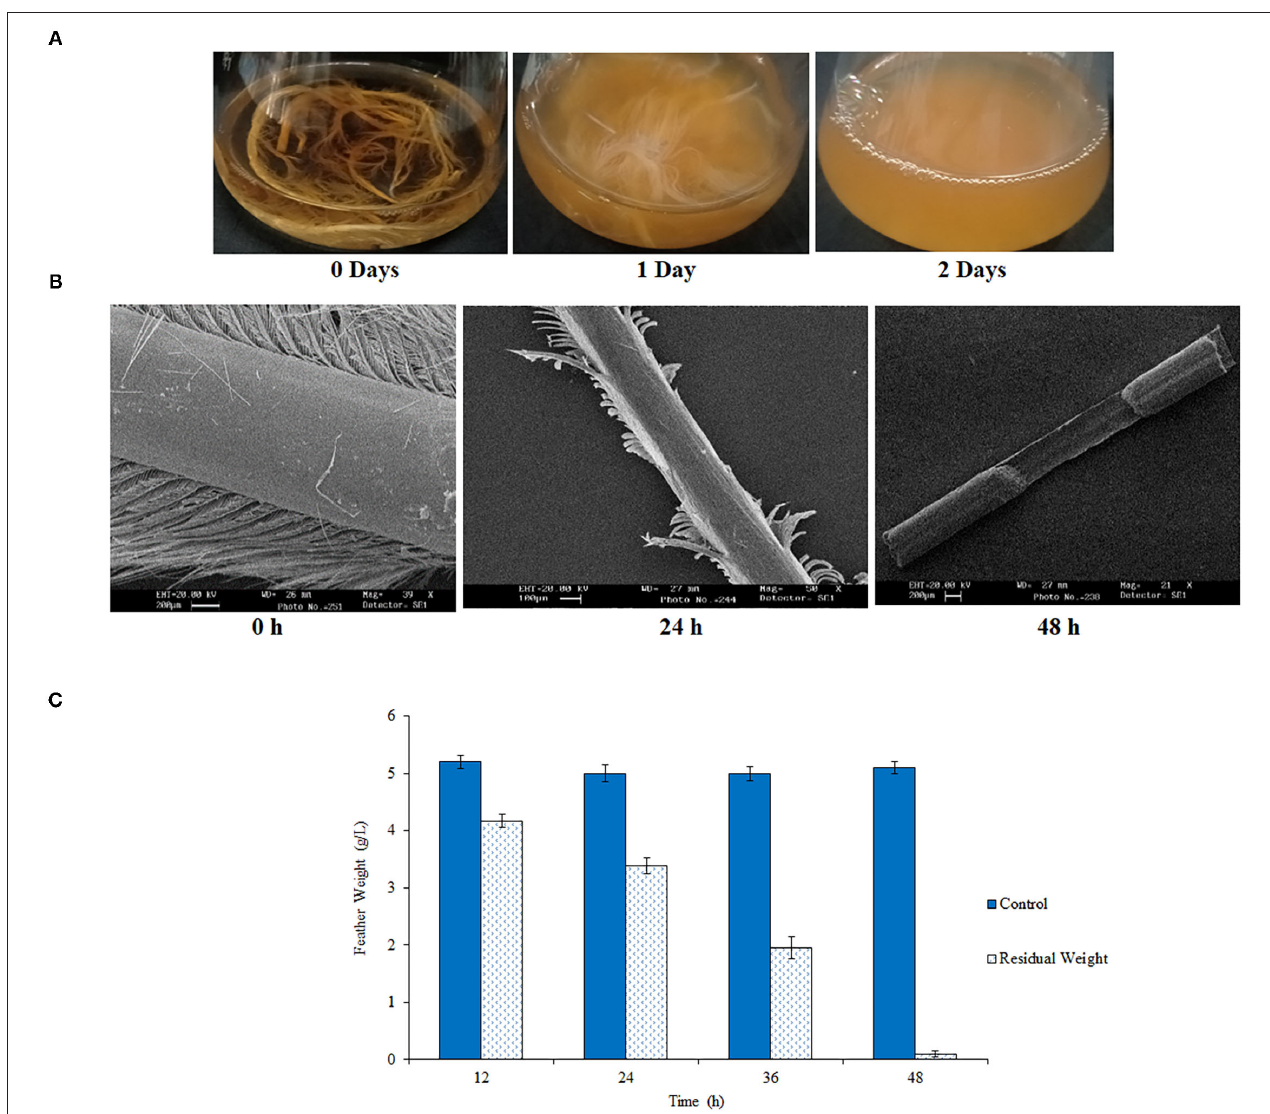
FIGURE 1 | Chicken feather degradation by RSA27. (A) RSA27 efficacy with respect to time at 180 rpm and 37 ◦ C. 0 days: control, 1 day: RSA27 initiated feather degradation after 24h, 2 days: complete degradation of feathers after 48h. (B) SEM of feather degradation at 0h (intact feather: control), 24h (degradation of feather barbs), and 48h (calamus degradation leading to complete degradation of the feather). (C) A residual dry weight of feathers after 12, 24, 36, and